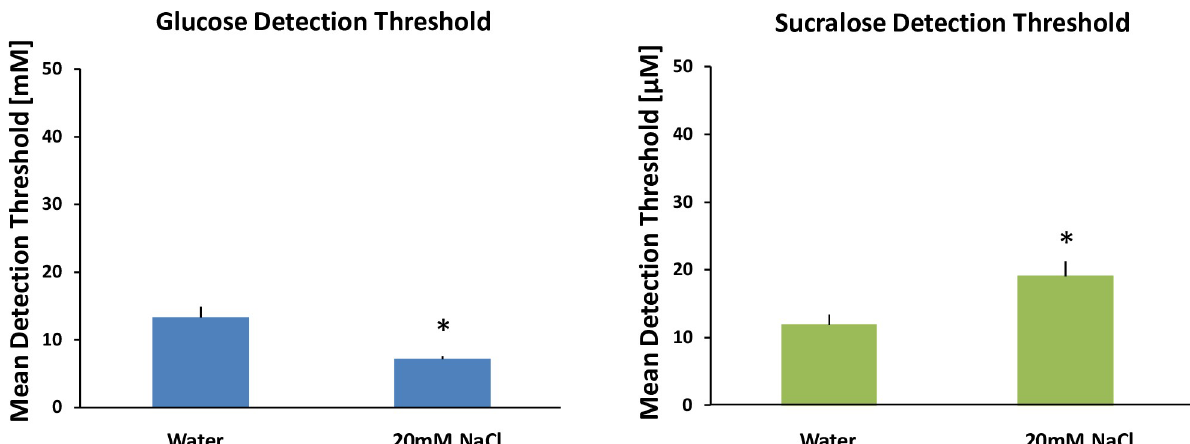
Fig 2. Mean glucose [mM] and sucralose [ μ M] detection thresholds with added NaCl. There are two bar charts in Fig 2. The left chart shows detection thresholds for glucose (blue). The right chart shows detection thresholds for sucralose (green). Each chart contains two bars. From left to right the bars are: 1) Detection threshold, 2) Detection threshold with 20mM NaCl added. 20mM NaCl was selected to match the concentration of glucose near threshold ~ 20mM. Thus, for each glucose molecule there would be a Na+ ion to be co-transported in theory. All treatments were paired with water rinses between stimuli. Twelve subjects participated in all conditions in duplicate. The error bars are standard error of the mean. � indicates significant difference, p < .0001.